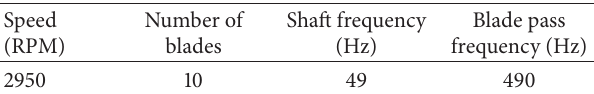
Table 1: Characteristic frequencies for test